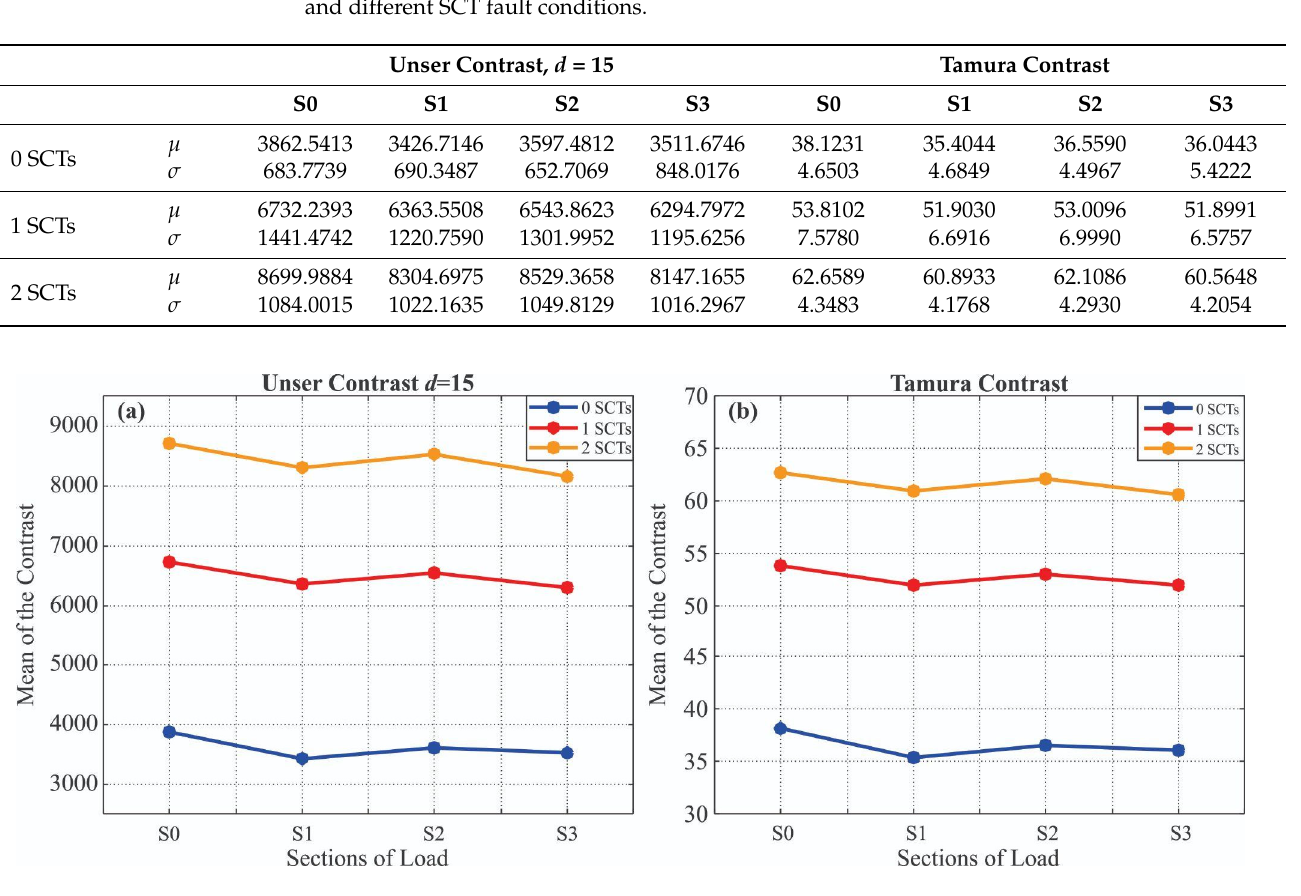
Figure 6. Mean ( μ ) of the contrast values for different loads: ( a ) Unser contrast with d = 15 and ( b ) Tamura contrast. ( b ) Tamura